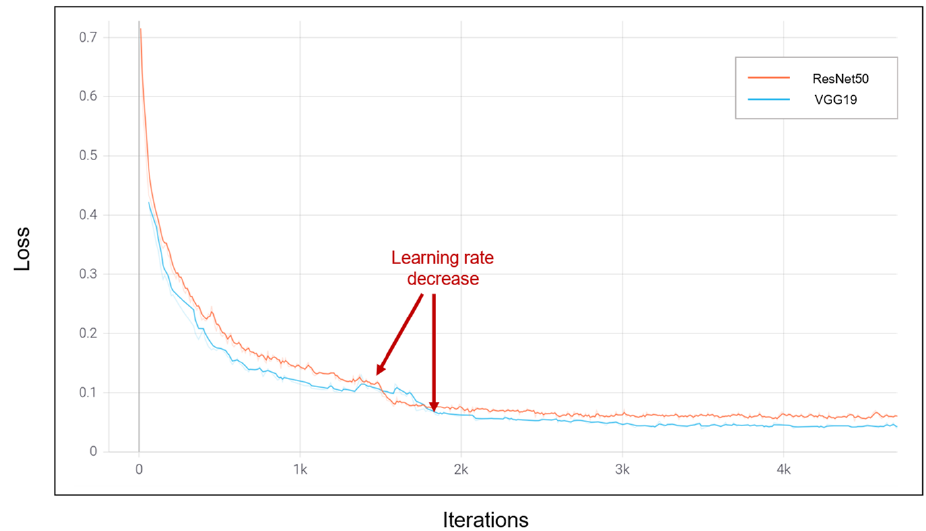
Figure 9. Training loss plots of VGG19 and ResNet50 models. The red arrows refer to the learning rate decrease which result in sudden change in the loss function.